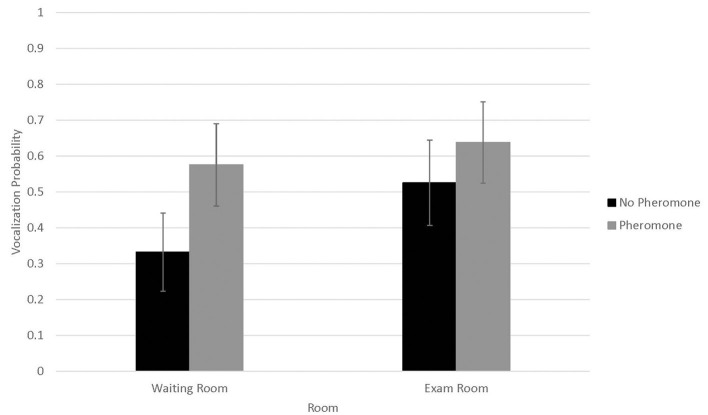
LSMean (±SE) feline vocalization probabilities during a 10-min acclimation period in a veterinary clinical exam room. Over four visits, 39 cats1 were randomly assigned to one of four possible treatment combinations (WR+/FFP+, WR+/FFP–, WR–/FFP+, WR–/FFP–),2 which were experienced for 10-min prior to the acclimation period and blood pressure measurements. 1All enrolled cats were mature, healthy, and either spayed or neutered. 2WR+: owners and their cats stayed in the waiting room lobby at veterinary clinic for 10 min prior to being taken into the exam room for blood pressure measurements; WR–: owners and their cats were immediately taken into the exam room where they waited for 10 min prior to blood pressure measurements; FFP+: a clean towel was sprayed with feline facial pheromone and placed in their carriers during the 10 min acclimation period; FFP–: no feline facial pheromone was provided.